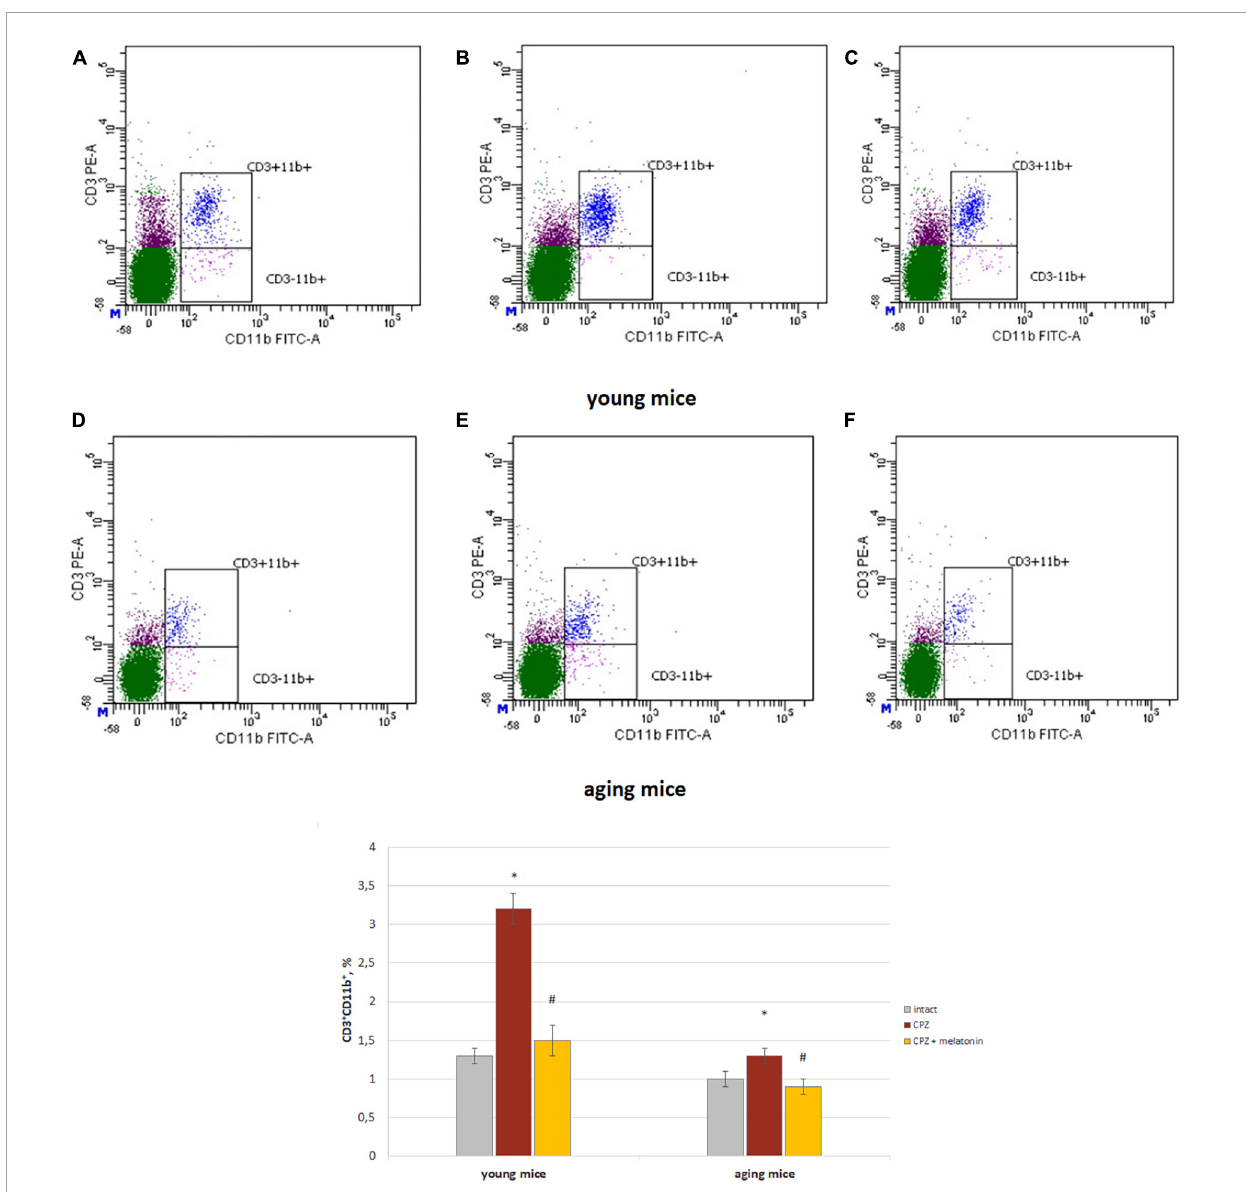
FIGURE3 Histograms of expression of CD3 and CD11b markers in the whole brain cells according to flow cytometry and the percentages of CD3+CD11b+ cells in the brain of young and aging mice of experimental groups ( n = 5 in each group). (A,D) Intact groups; (B,E) cuprizone treated groups; (C,F) cuprizone + melatonin groups. Represented data are in 3 weeks of cuprizone (CPZ) diet. Data are M ± SEM. ∗ p < 0.05 compared to intact group; # p < 0.05 compared to CPZ ( t -test).